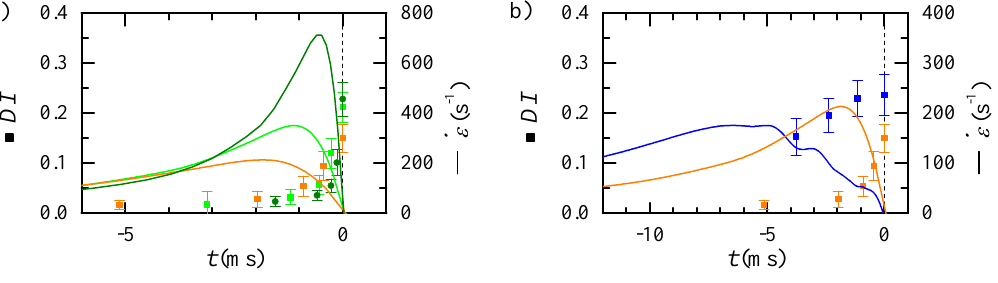
Figure 14. Temporal evolution of the particle deformation (symbols) and numerically calculated strain rate (lines) for: ( a ) nozzle 8, and different Q = 3 µ L/min (orange), Q = 5 µ L/min (light green) and Q = 10 µ L/min (dark green); and ( b ) nozzle 6 and Q = 5 µ L/min (blue) and nozzle 8 and Q = 3 µ L/min